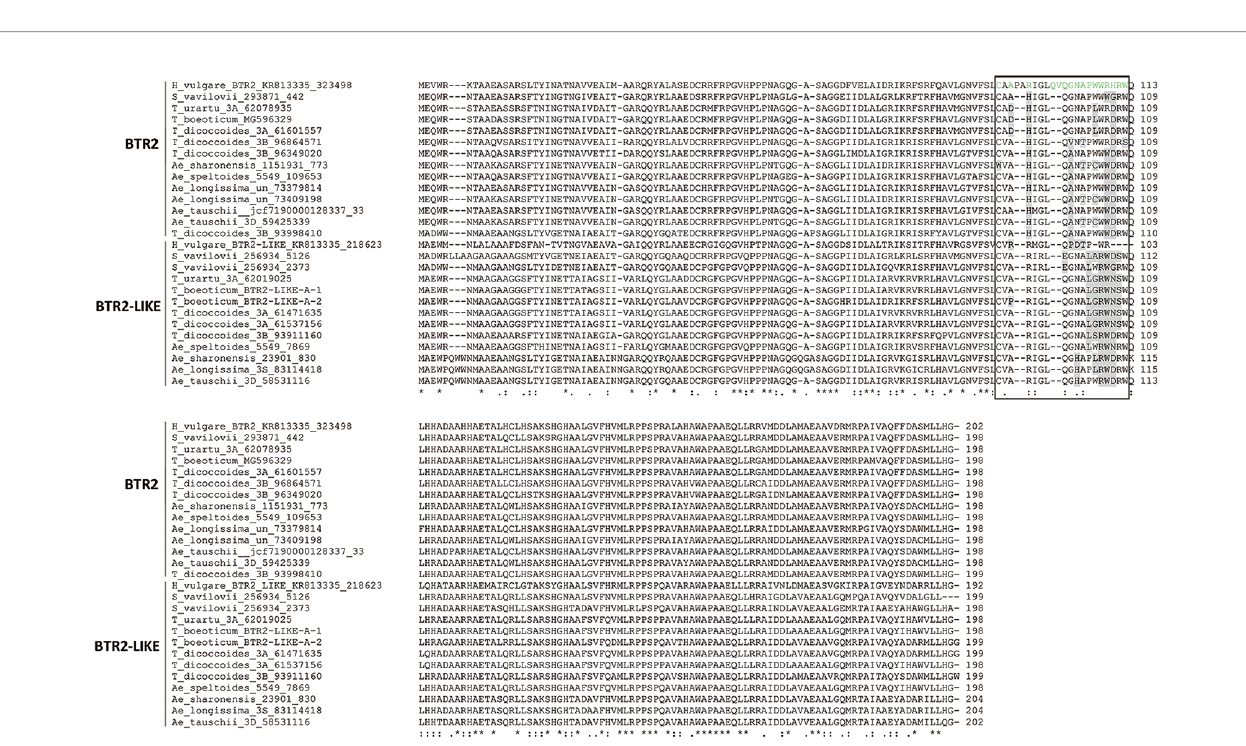
Frontiers in Plant Science |